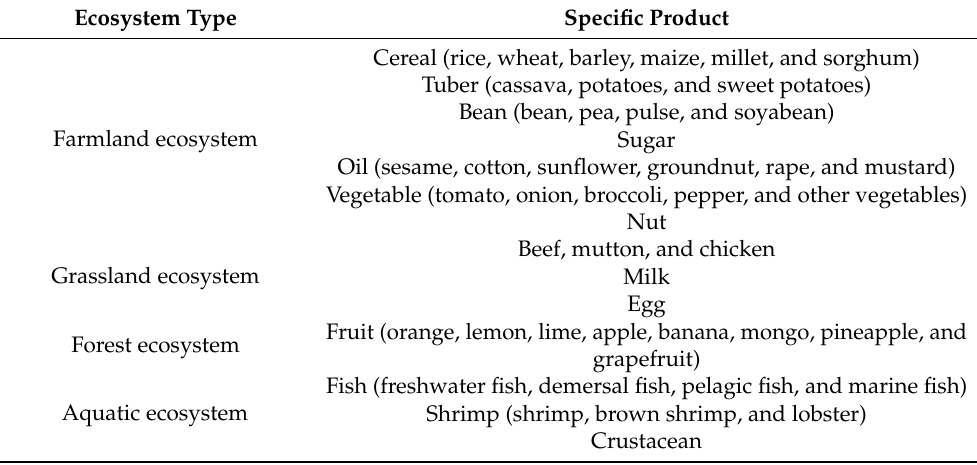
Table 1. Consumption category for the products provided by ecosystem. Ecosystem